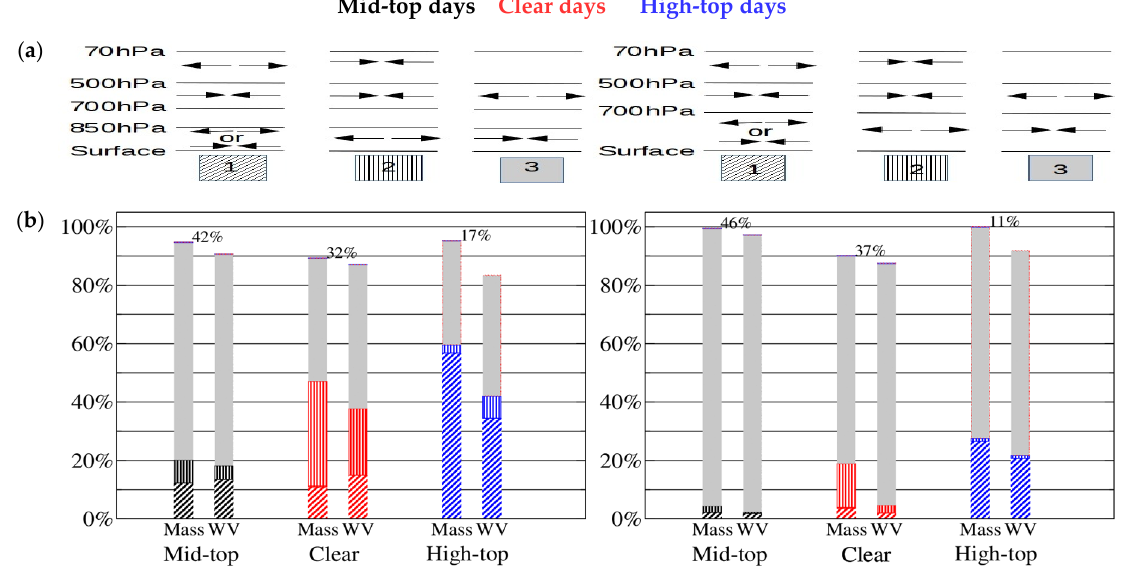
Figure 13. ( a ) For each of the 3 classes of convergence profile, the pressure levels and the sign of convergence value (indicated by the convergence or divergence of the two arrows) used to perform the classification. ( b ) for the mass (Mass) and for the water vapor (WV), occurrence frequency distribution of the convergence profiles in the 3 type classification for mid-top days, clear days and high-top days in JJAS. Information is given for West-Sahara (left column) and Hoggar (right